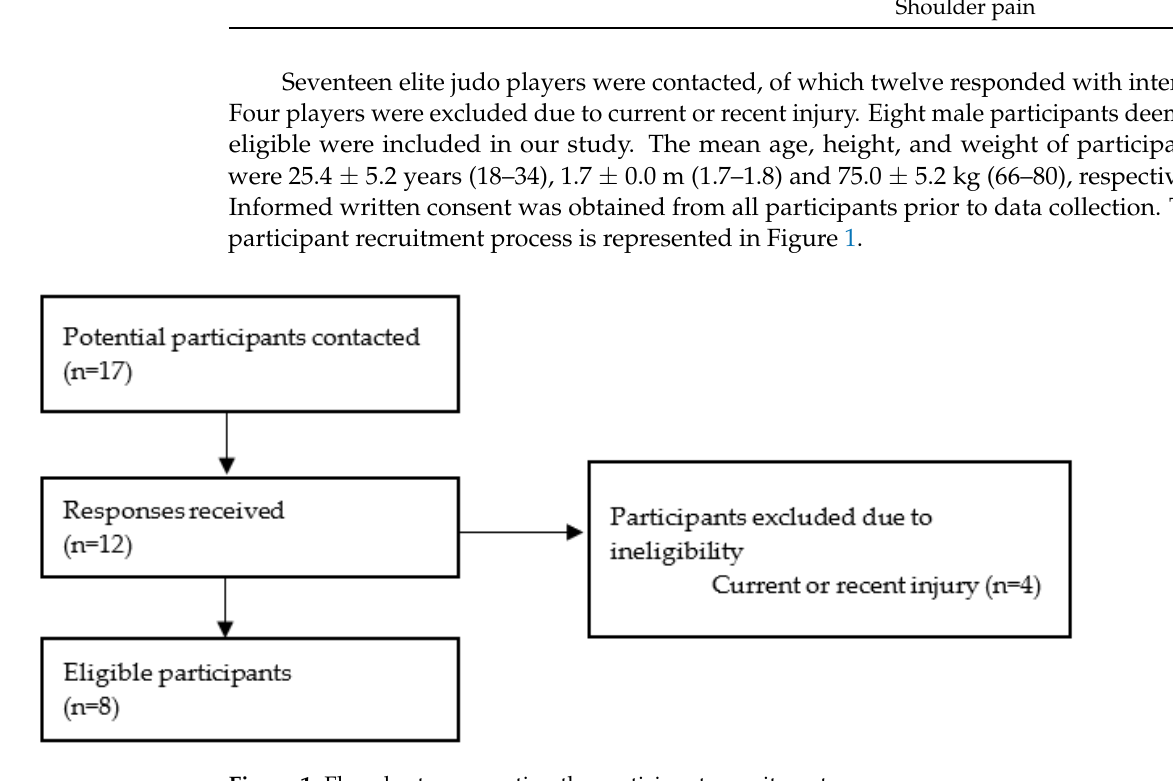
Figure 1. Flowchart representing the participant recruitment process.